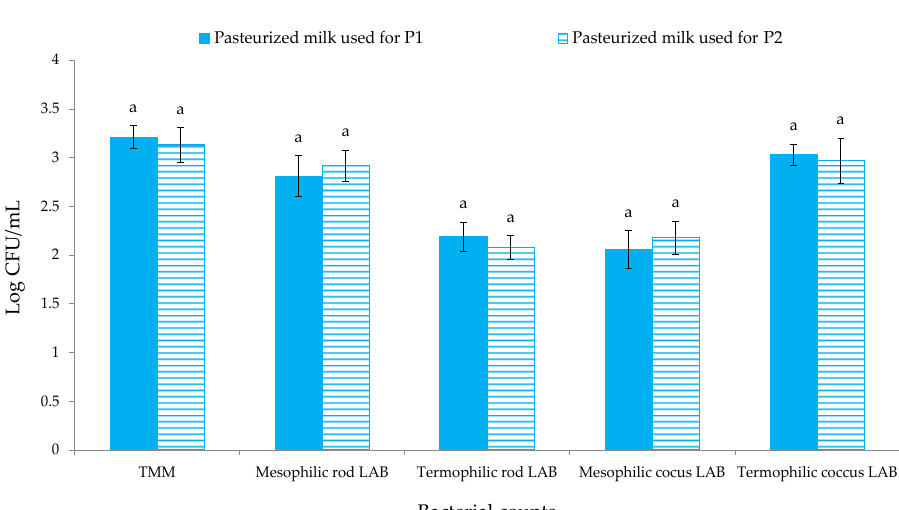
Figure 2. Microbial loads (Log CFU/mL) of pasteurized milk samples. Results indicate mean values and standard deviation of six determinations (carried out in duplicate for three independent productions). Abbreviations: P1, production performed with starter culture SF1 (starter formulation CR/A); P2, production performed with starter culture SF2 (starter formulation LYOBAC-D CRM); TMM, total mesophilic microorganisms; LAB, lactic acid bacteria.